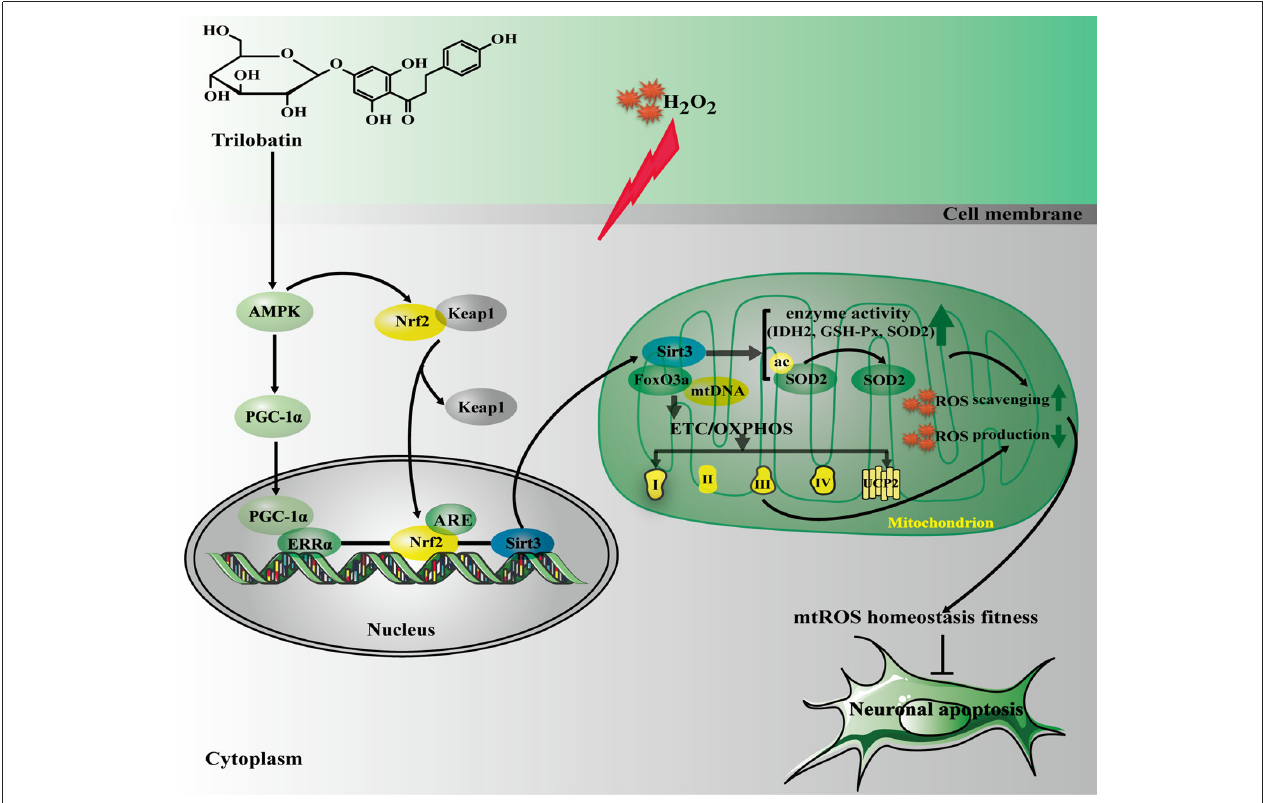
FIGURE 8 | The schematic presentation elucidating proposed mechanisms that TLB protects PC12 cells against oxidative stress-induced injury. Excessive mitochondrial reactive oxygen species (mtROS) production is triggered by H 2 O 2 leading to oxidative injury in neuronal cell, and even apoptosis. TLB mitigates overproduction of mtROS and amelioriates the damage of mitochondrial respiratory chain induced by H 2 O 2 through mediating the AMPK/Nrf2/Sirt3